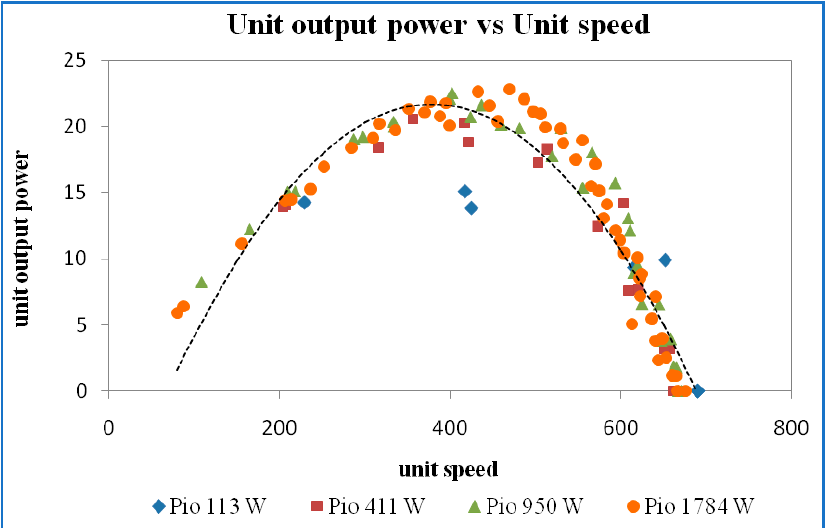
Figure 32. Unit output power vs. unit speed at a guide vane opening of 16 mm. This curve at a unit speed value of 400 rpm attained maximum efficiency.